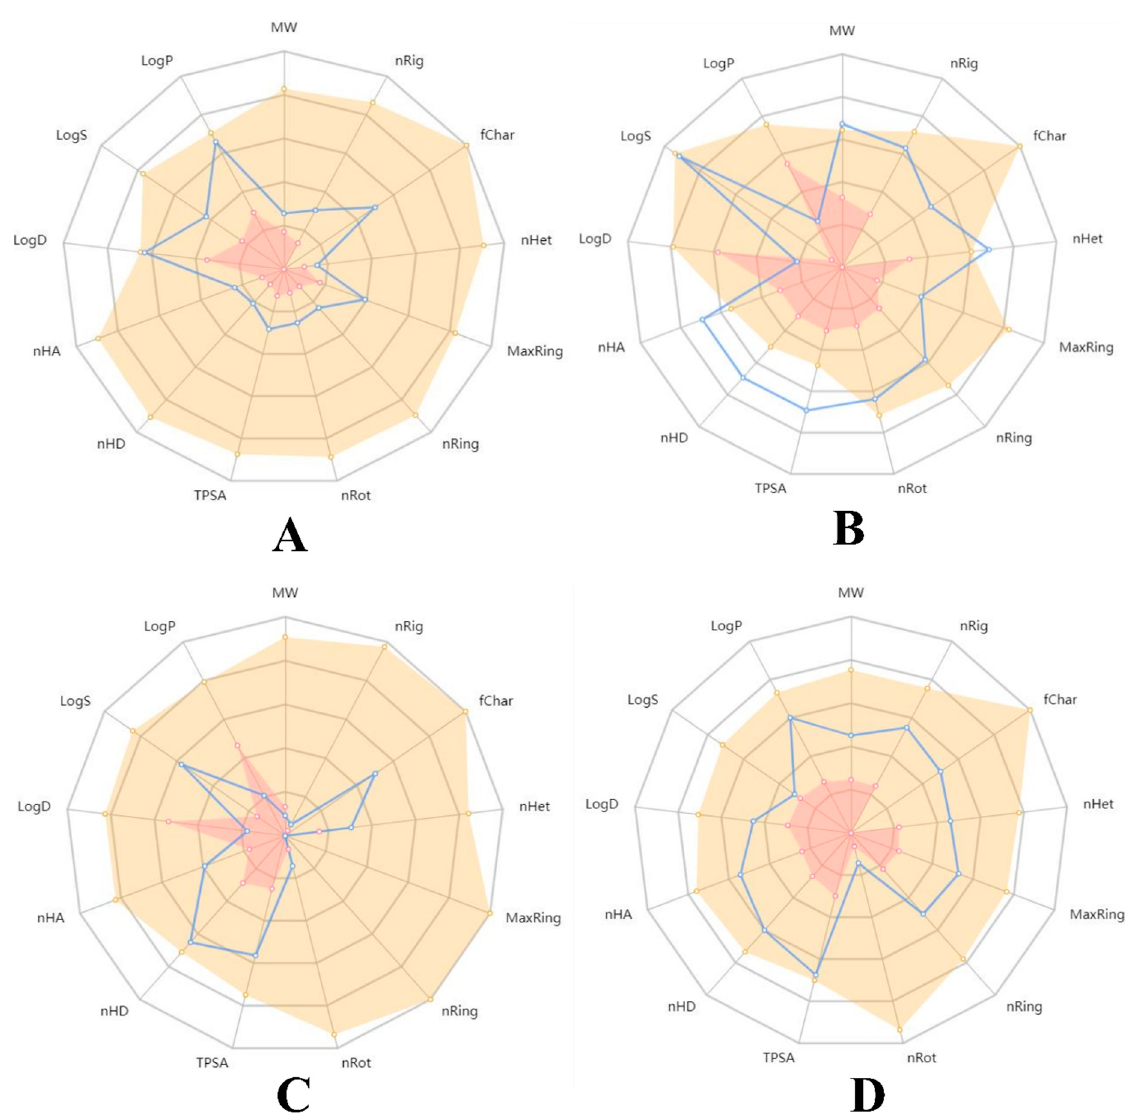
Figure 9. Pharmacokinetic mapping of the representative compounds: ( A ) isoeugenol, ( B ) acarbose, ( C ) aminoguanidine, and ( D ) quercetin. Table 9. Druglikeness and pharmacokinetic properties of the representative compounds.